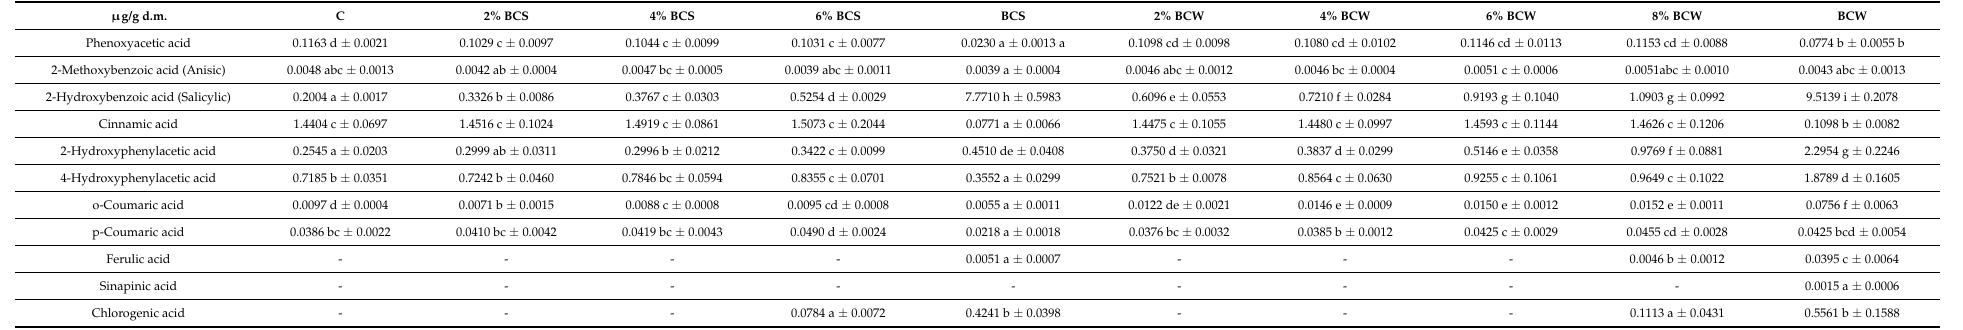
Table 4. Phenolic acids detected by GC-MS analysis in starch bread with BCS and BCW. µ